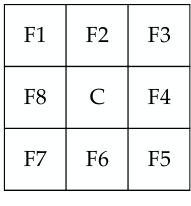
Figure 3. Surrounding structure of the pixel C. Figure 4. Surrounding structure of the pixel